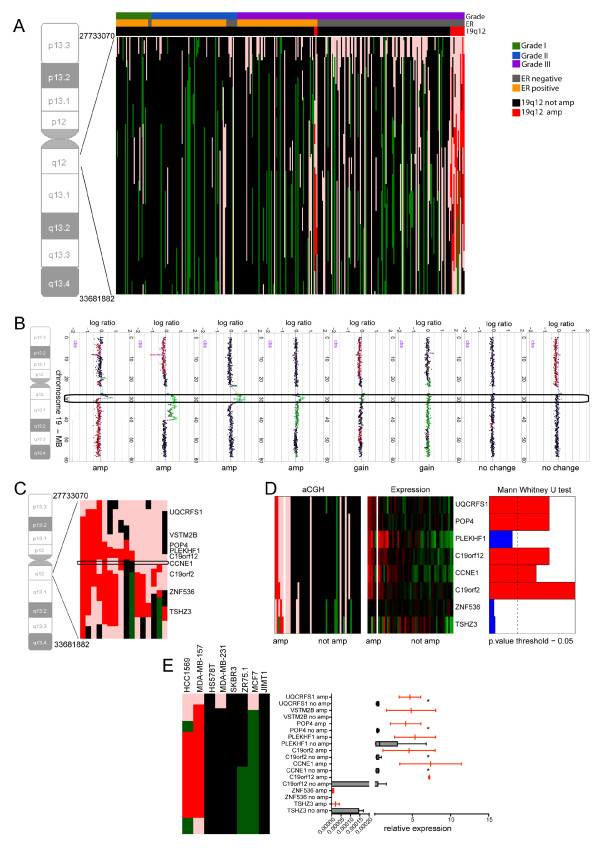
Patterns of 19q12 amplification and mRNA expression of genes mapping to the 19q12 amplicon. (A) aCGH heatmap of chromosome 19q12 in 313 primary breast cancers. Tumours were ordered according to histological grade, oestrogen receptor (ER) status and 19q amplification status. (B) Chromosome 19 ideogram and aCGH plots illustrating the patterns of 19q12 amplification (bright green, amp), copy number gain (green, gain) and no copy number change (black, no change) in primary breast cancers. (C) aCGH heatmap of region of amplification in 16 breast cancers harbouring amplification of the 19q12 locus. CCNE1 (box) was amplified in 5/16 cancers. (D) Heatmaps depicting aCGH states (left) and gene expression values (middle) in 48 primary breast cancers with or without 19q12 amplification. Genes are ordered according to their chromosomal position and tumours grouped according to the 19q12 amplification status. Bar plots (right) depict the Mann-Whitney U test results for the comparison of gene expression as a continuous variable and gene amplification as the grouping variable. In red, genes with P-values < 0.05 (dotted line). (E) aCGH heatmap of the 19q12 amplicon in breast cancer cells with (MDA-MB-157, HCC1569) or without (MDA-MB-231, Hs578T, MCF7, ZR75.1, BT474, JIMT1) 19q12 amplification. Box-and-whiskers plots showing the expression of genes within the amplified region in cell lines with (red) and without (grey) 19q12 amplification. *: genes significantly overexpressed when amplified (Mann-Whitney U test, P
< 0.05). In all aCGH heatmaps (A, C, D, E), green: copy number loss, black: no copy number change; pink: copy number gain; bright red: gene amplification. In the microarray gene expression heatmap (D), green: down-regulation; red: up-regulation.